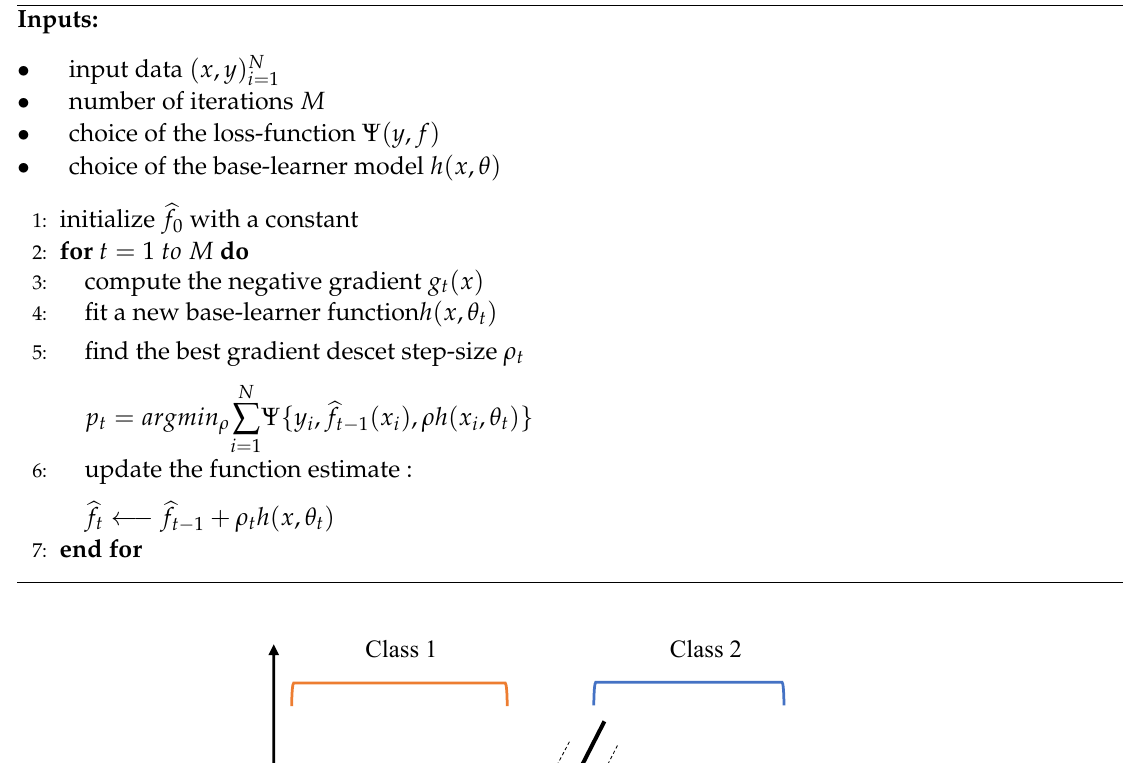
Algorithm 1 Friedman’s Gradient Boosting Algorithm [31].